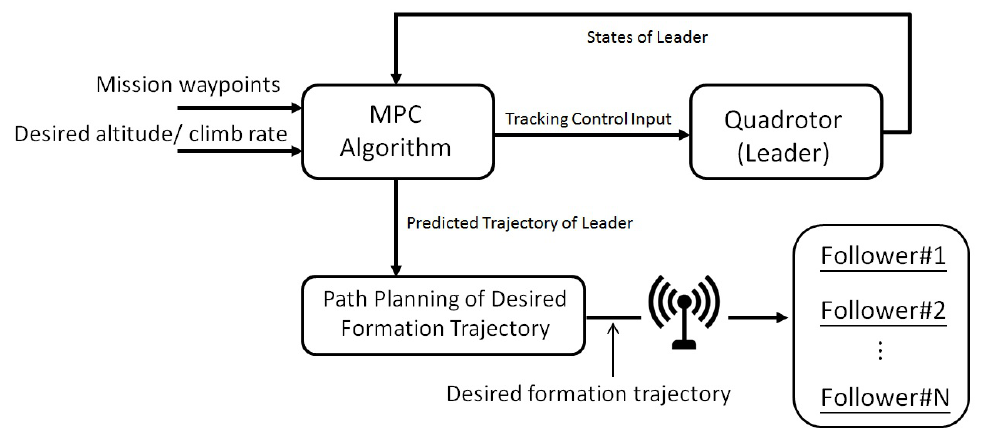
Figure 3. Formation control strategy of the leader.